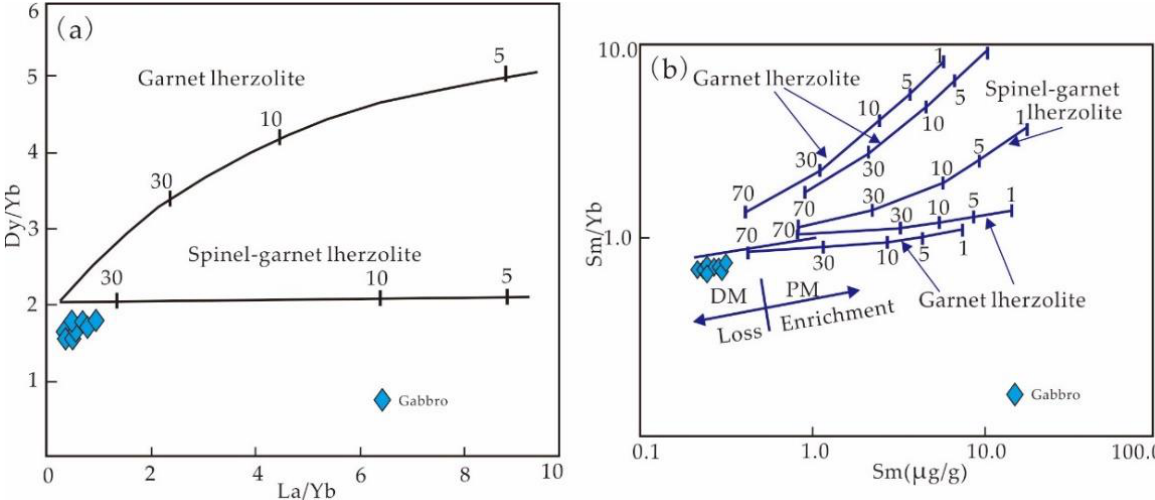
Figure 9. ( a,b ) Source characteristics of gabbro rock, Laguoco, Tibet, modified after [39,40]. Figure 9. ( a , b ) Source characteristics of gabbro rock, Laguoco, Tibet, modified after